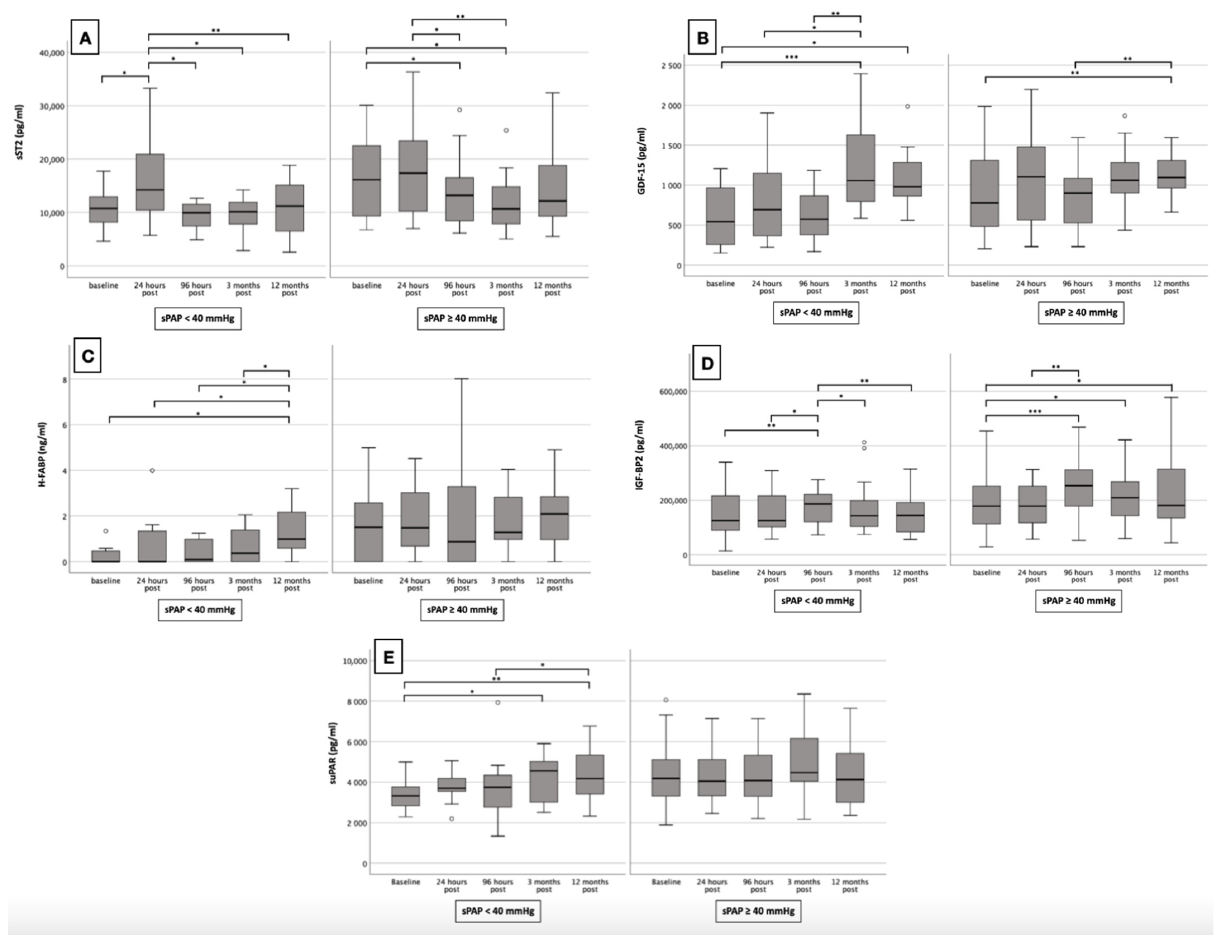
Figure 1. Serum concentrations of several biomarkers in patients with an sPAP < 40 mmHg and with an sPAP ≥ 40 mmHg. * p ≤ 0.05; ** p ≤ 0.01; *** p ≤ 0.001. ( A ): sST2; ( B ): GDF-15; ( C ): H-FABP; ( D ): IGF-BP2; ( E ): suPAR. Table 2. Tabular comparison of all collected cardiovascular biomarkers at baseline and 24 h, 96 h, 3 months, and 12 months after TAVR in patients with an sPAP < 40 mmHg and an sPAP ≥ 40 mmHg. sST2: soluble suppression of tumorigenicity-2; GDF-15: growth differentiation factor-15; H-FABP: heart-type fatty acid binding protein; IGF-BP2: insulin-like growth factor binding protein 2; suPAR: soluble urokinase-type plasminogen activator receptor. Bold numbers: p ≤